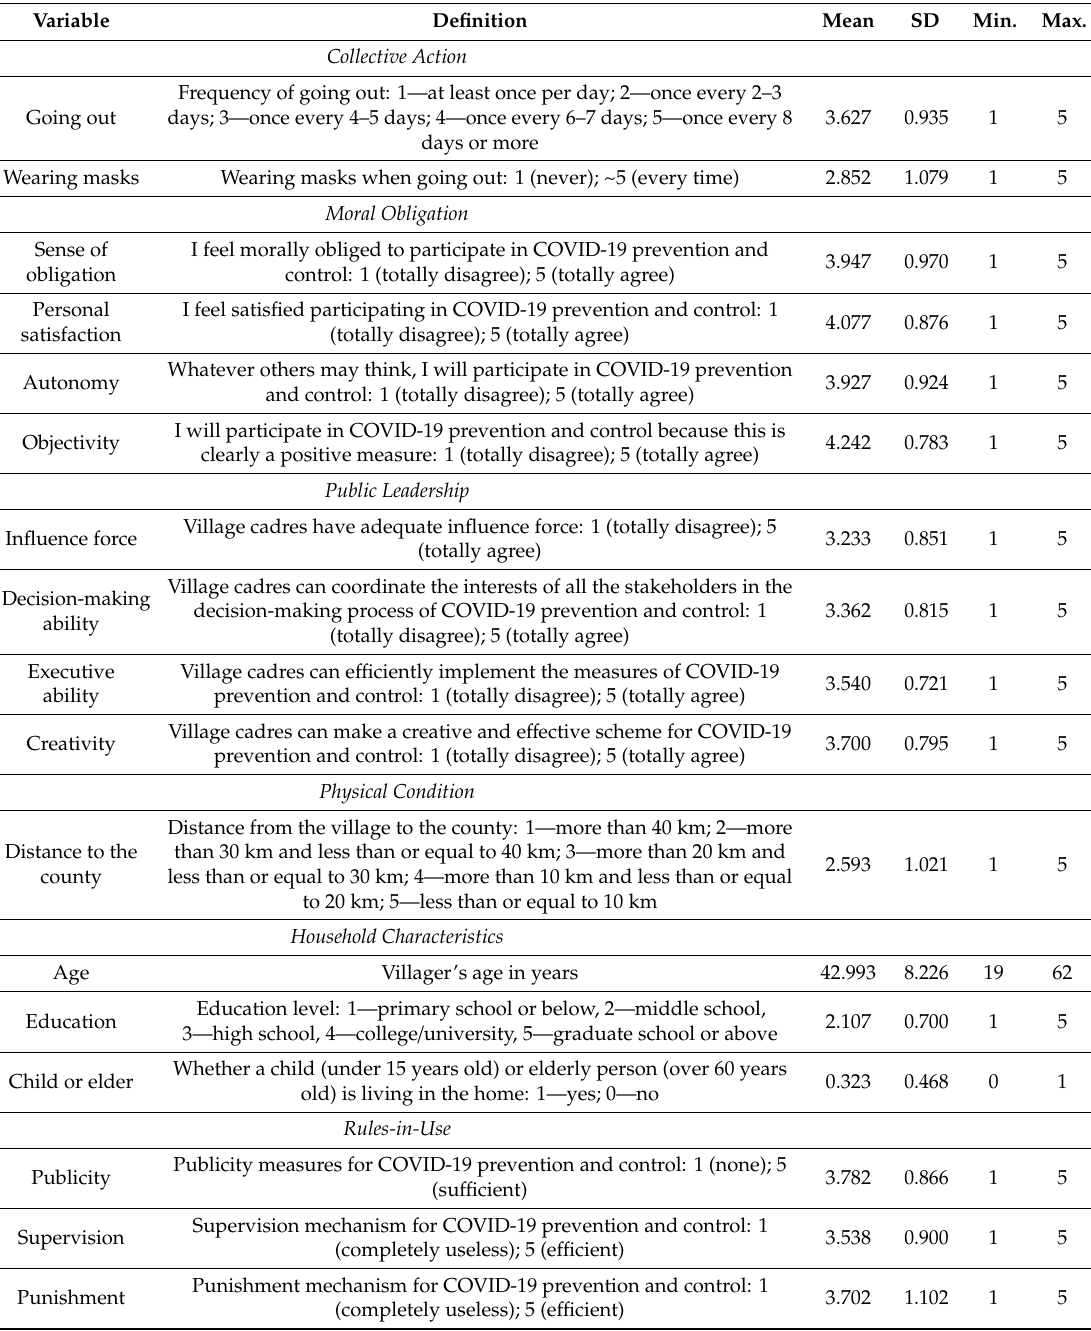
Table 1. Definitions and summary statistics of the